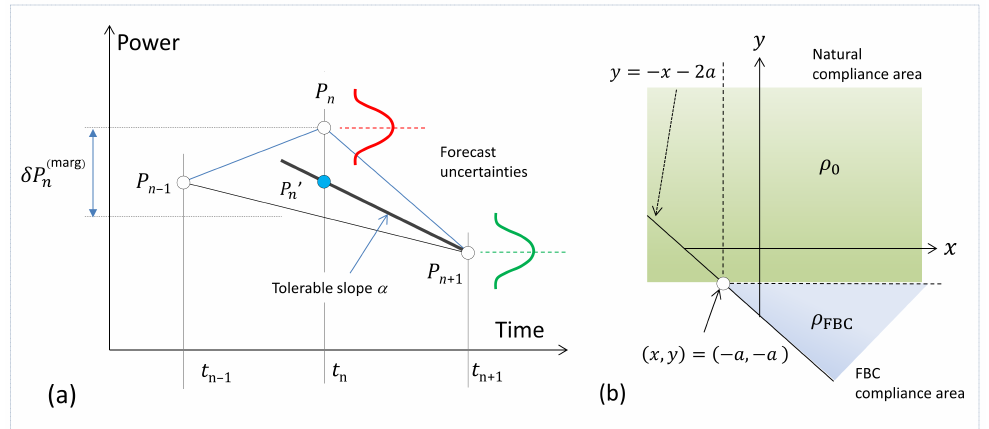
Figure 1. Basic idea of forecast-based curtailment: ( a ) Three events on the output power time line; P n − 1 is the last measured event, P n and P n + 1 lie in the future. ( b ) Compliance areas in the x - y -plane, where the x p = P n − P n − 1 and y p = P n + 1 − P n